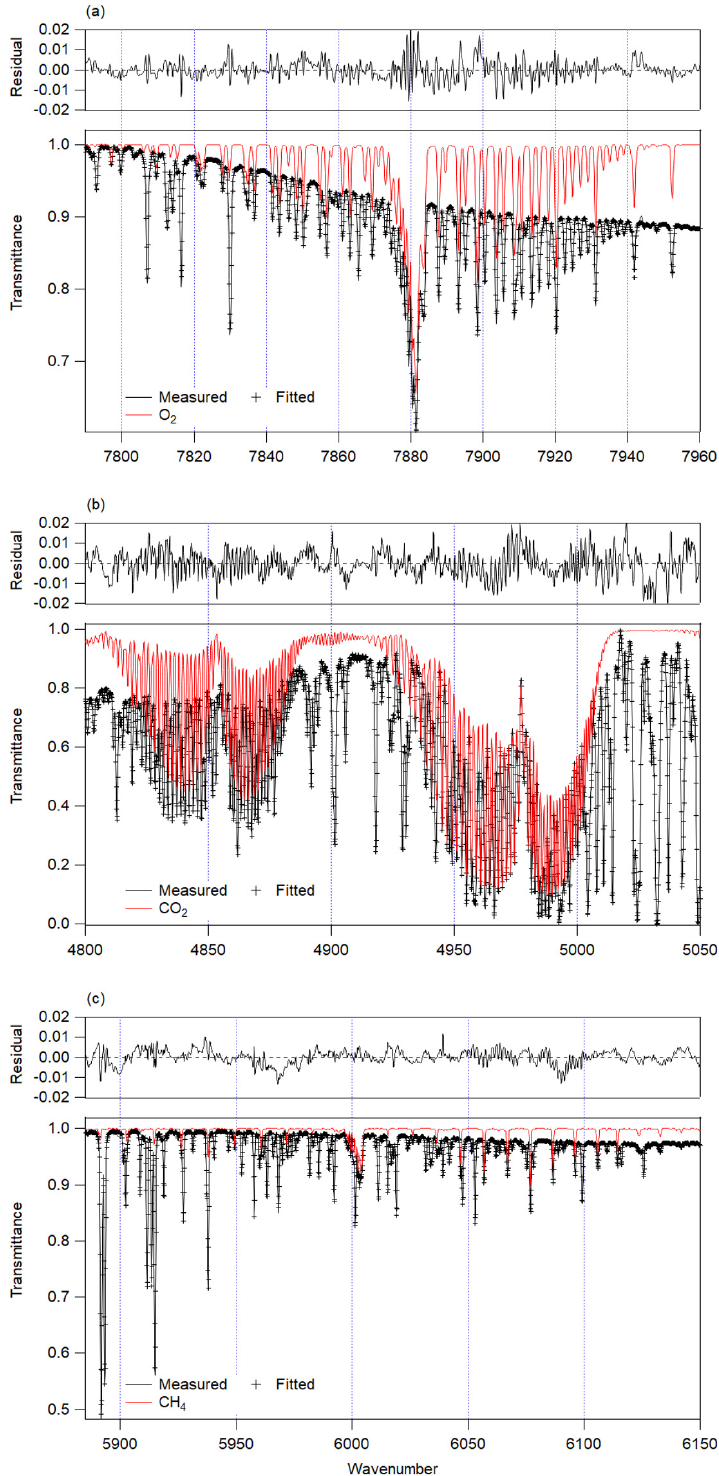
Figure 4. Typical fits for (a) O 2 band centred near 7880cm − 1 (b) CO 2 bands centred near 4850 and 4980cm − 1 and (c) CH 4 band centred near 6000cm − 1 . In each plot the target species is in red, and the remaining absorption is dominated by water vapour. See Table 1 for details of all interfering and co-fitted